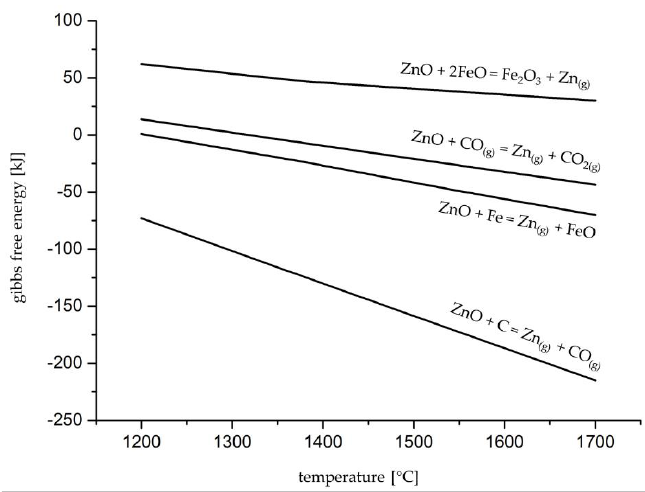
Figure 1. Change in free enthalpy of reaction with increasing temperature for possible zinc oxide